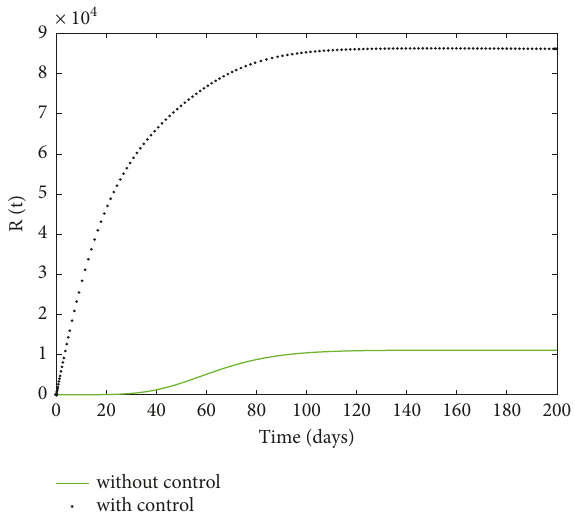
Figure 22: Behaviour of the individuals removed from COVID-19 with and without vaccination